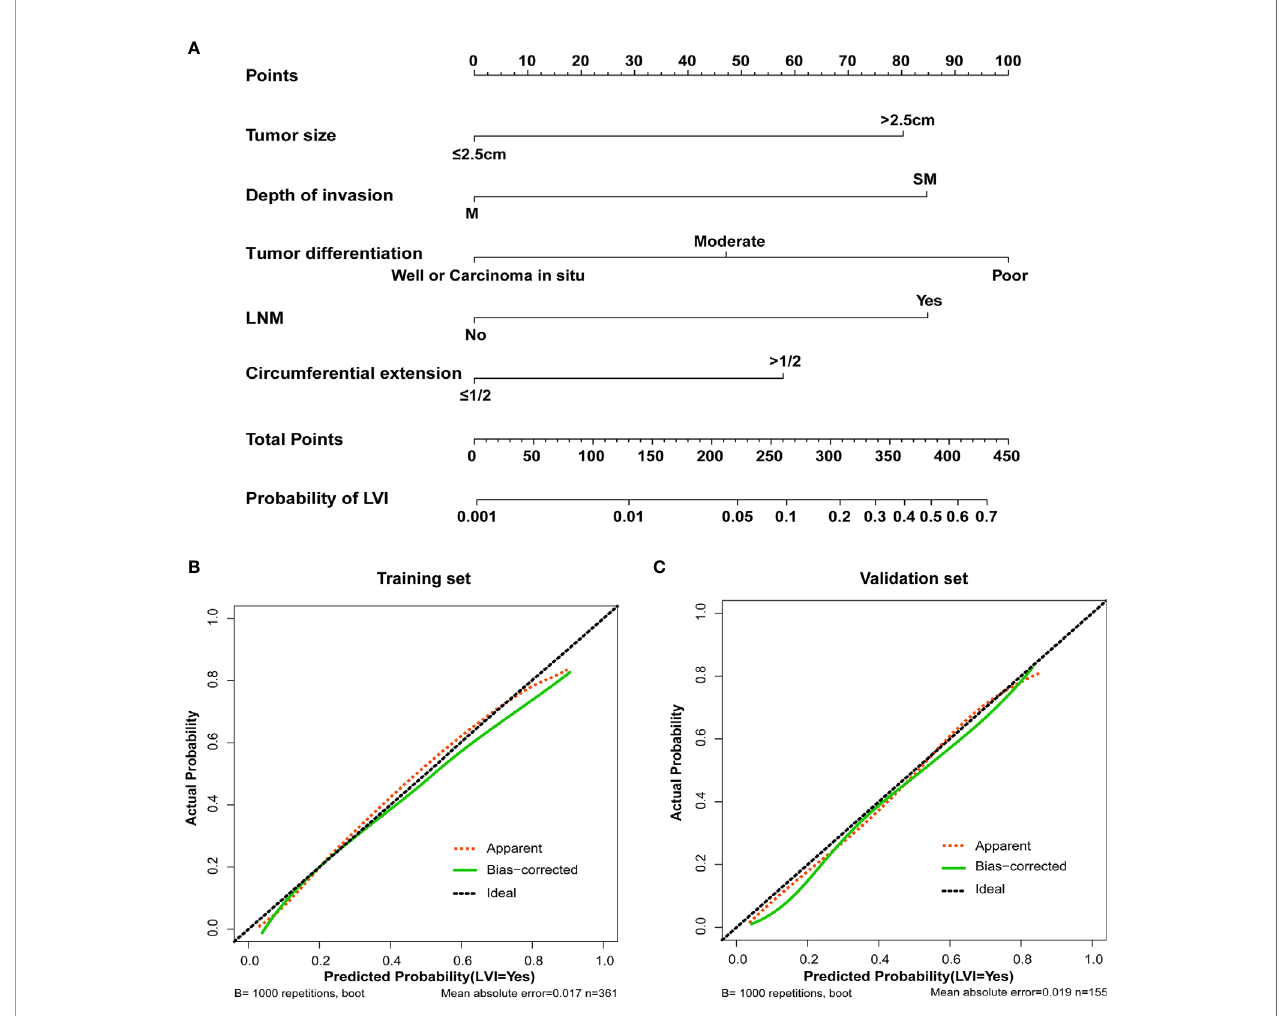
FIGURE 3 | The nomogram and its calibration. (A) Nomogram for predicting the probability of lymphovascular invasion in patients with super fi cial esophageal squamous cell carcinoma in training set. Locate the patient ’ s characteristic on a variable row and draw a vertical line straight up to the points ’ row (top) to assign a point value for the variable. Add up the total number of points and drop a vertical line from the total points ’ row to obtain the probability of lymph node metastasis. The calibration curve based on internal validation with a bootstrap resampling frequency of 1000 in the training cohort (B) and validation set (C)